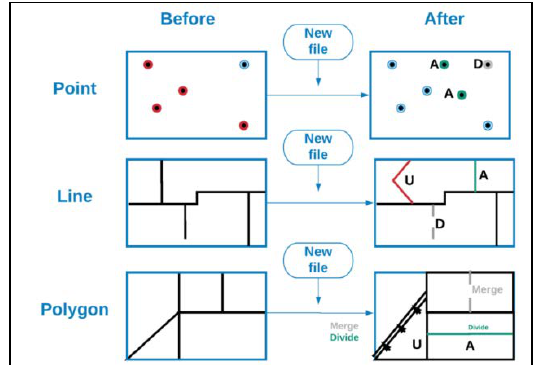
Figure 4: the three operations of the conflation process.